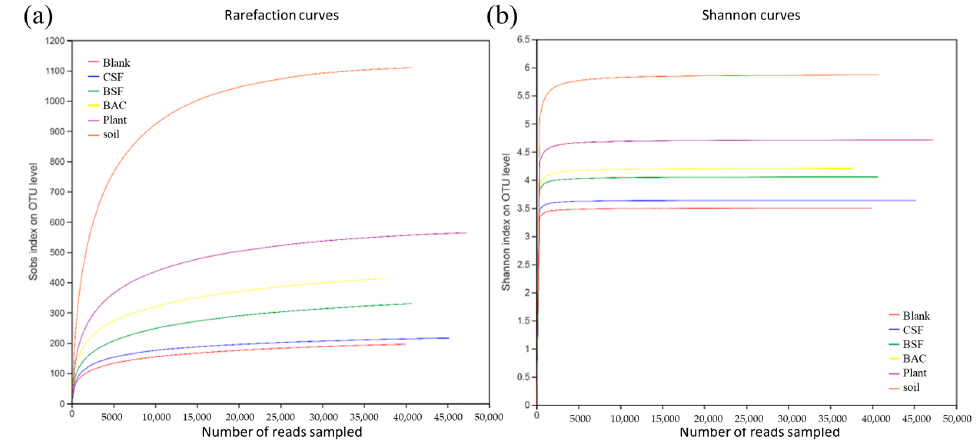
Figure 6. ( a ) Rarefaction curve; and ( b ) Shannon index curve.